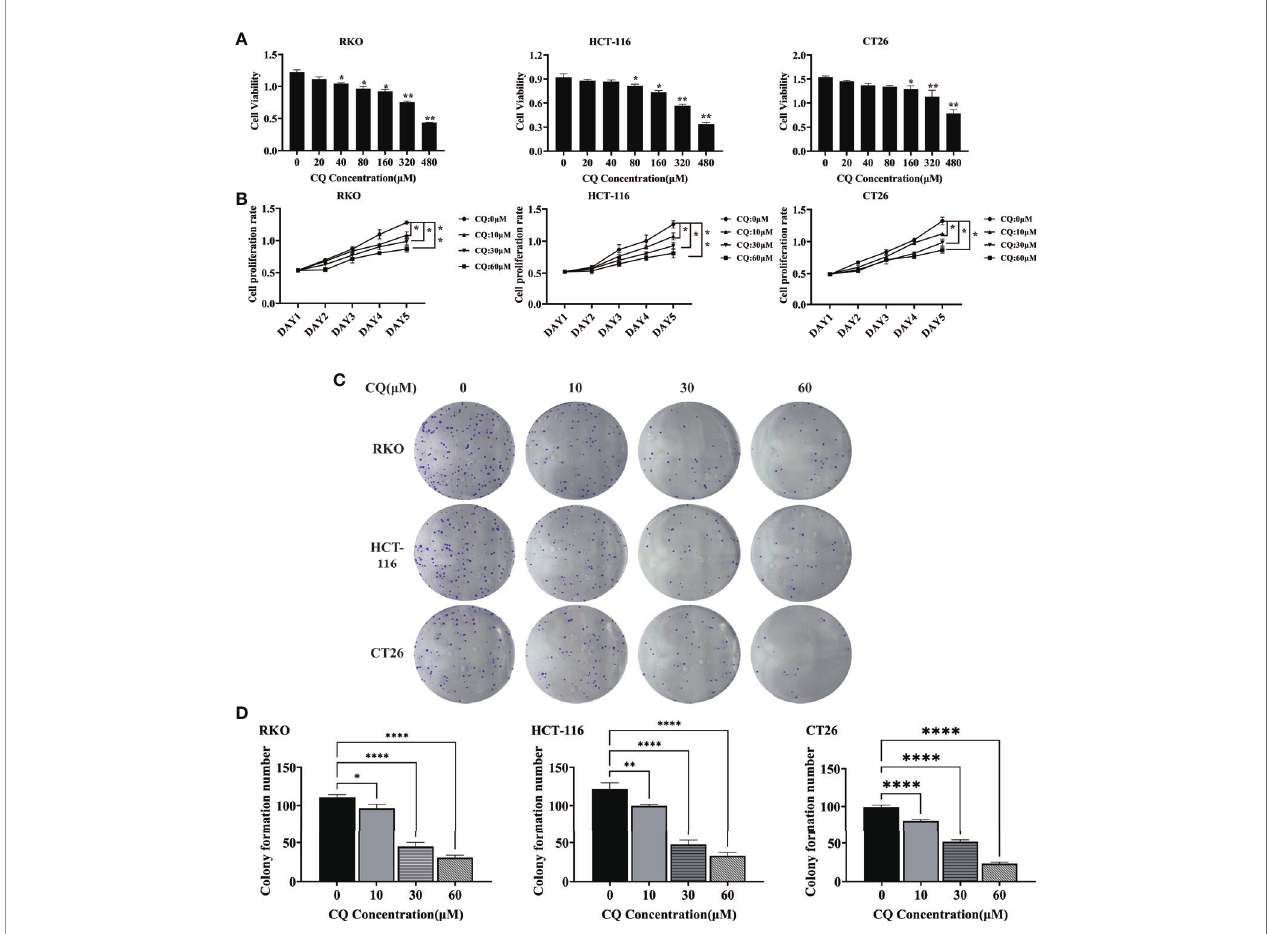
FIGURE 1 | Chloroquine inhibits the survival and proliferation of colorectal cancer cells. (A) The cell viability of RKO, HCT-116 and CT26 was detected by CCK8 assay. (B) The cell proliferation of RKO, HCT-116 and CT26 was detected by CCK8 assay. (C, D) The cell proliferation of RKO, HCT-116 and CT26 was detected by colony-forming assay. (* p < 0.05, ** p < 0.01, **** p < 0.0001 vs 0 m M